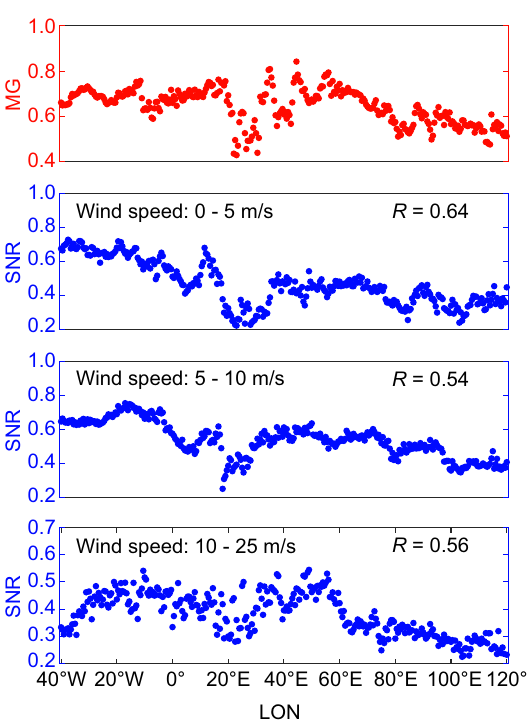
Fig. 4 The correlation between SNR and marine gravity